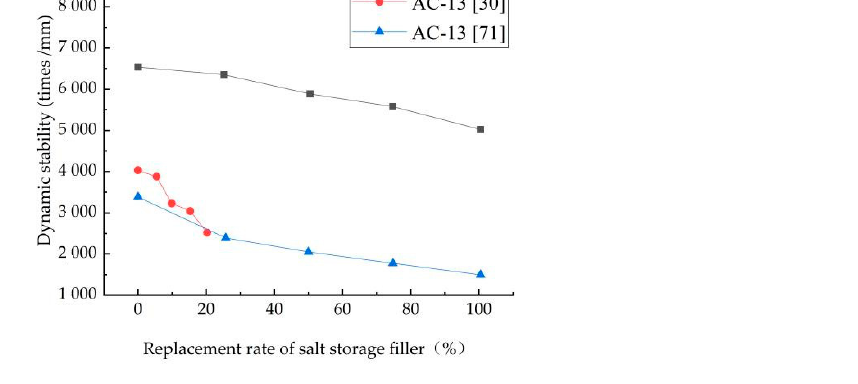
Figure 4. Rutting test of the same types of salt-storage mixture. (Shao 2015 [30], Dou 2015 [60], Sun 2011 [71])